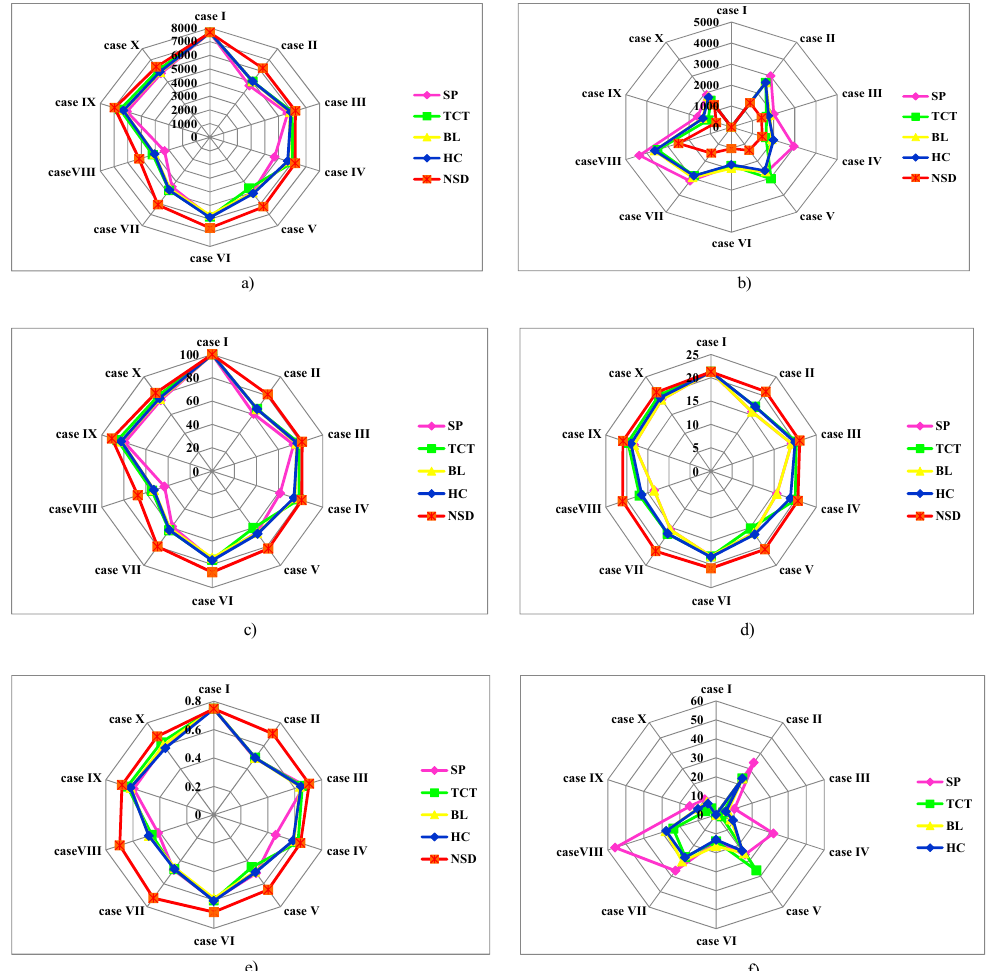
Figure 8. Performance evaluation parameter ( a ) GMPP (W), ( b ) MP(W), ( c )%O/P, ( d ) η , ( e ) FF, ( f ) %PE.